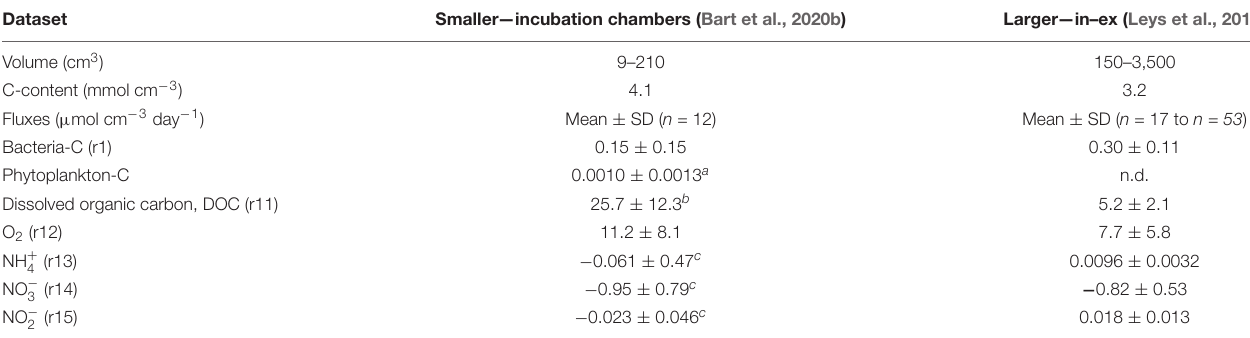
TABLE 1 | Experimental metabolic datasets of intact Geodia barretti sponges (Leys et al., 2018; Bart et al., 2020b) which were analyzed with the metabolic network model.